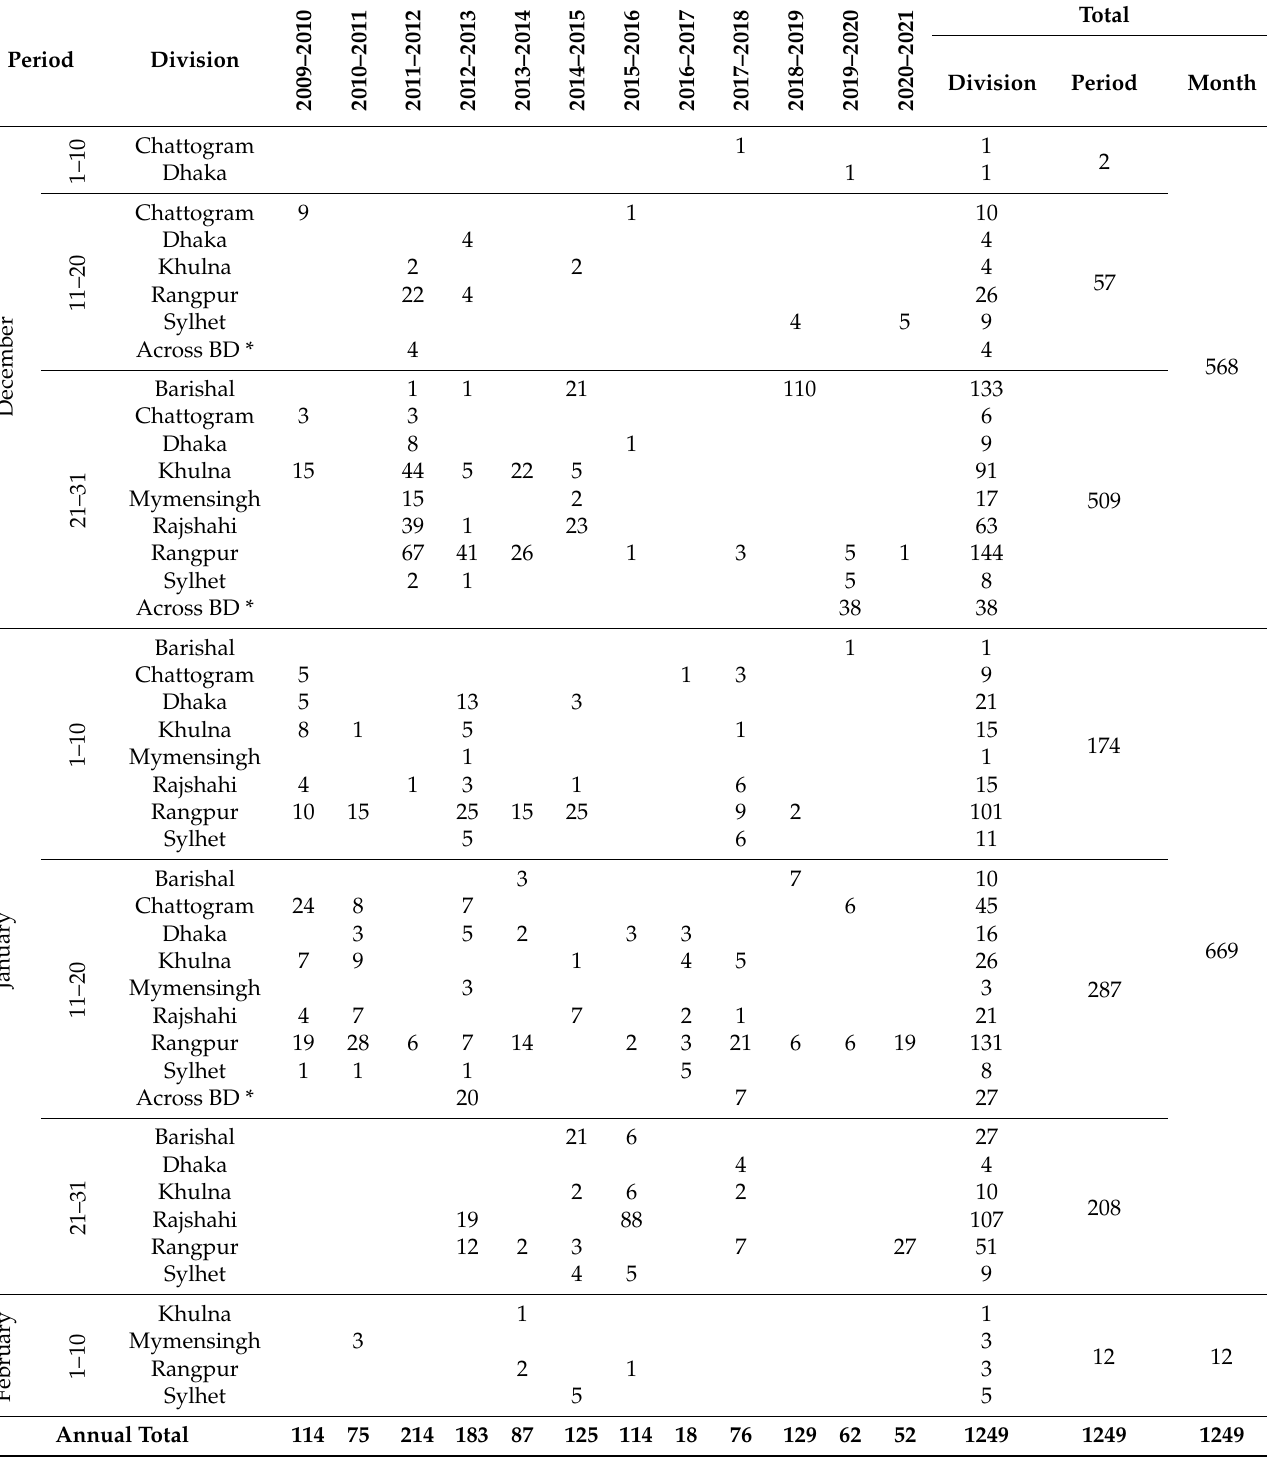
Table 1. Cold-related mortality occurring within 10-day periods in winter months in the divisions of Bangladesh during